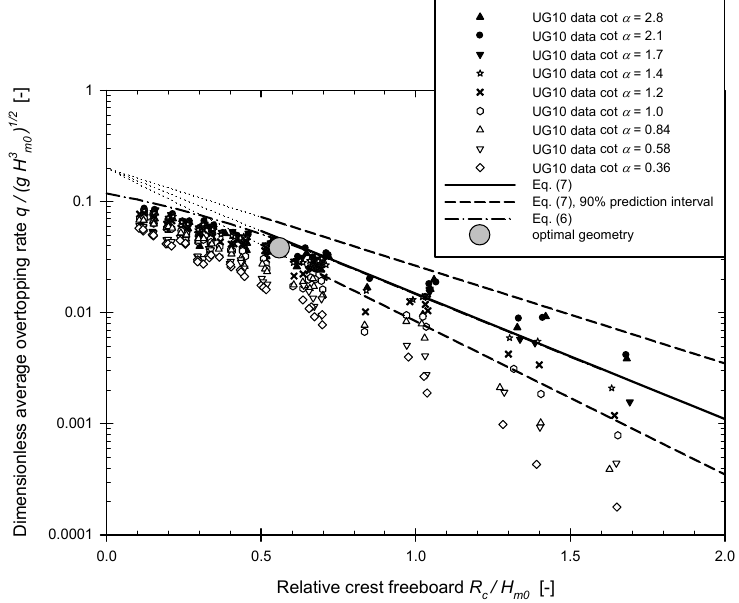
Figure 2. Log-linear graph of dimensionless average overtopping rate (logarithmic scale) as a function of the relative crest freeboard (linear scale) for the test results of the UG10 R H varying between 0.0 and 2.0. Grey dot indicates the point of dataset, with / 0 c m optimal